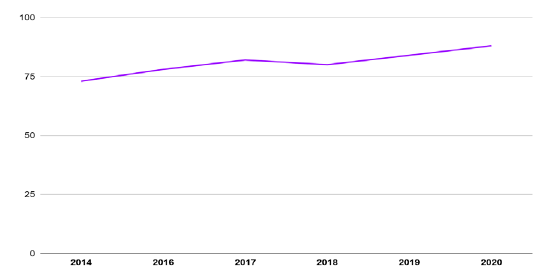
Figure 8. Performance of students: Years vs Average score of students by percentage